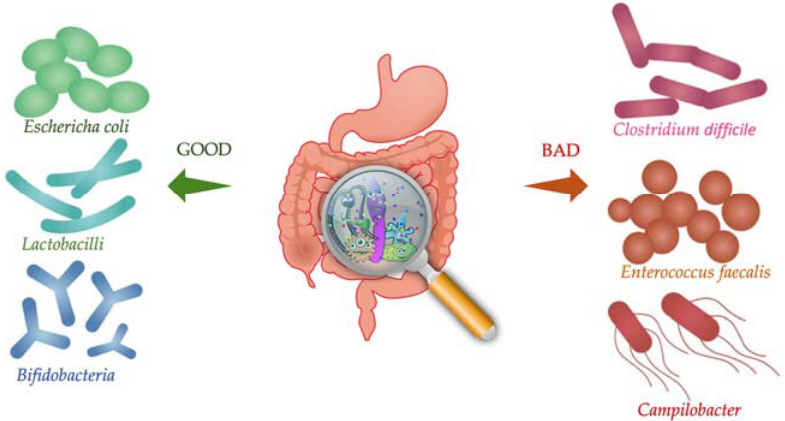
Figure 3. Effects of bacterial species on arterial hypertension.